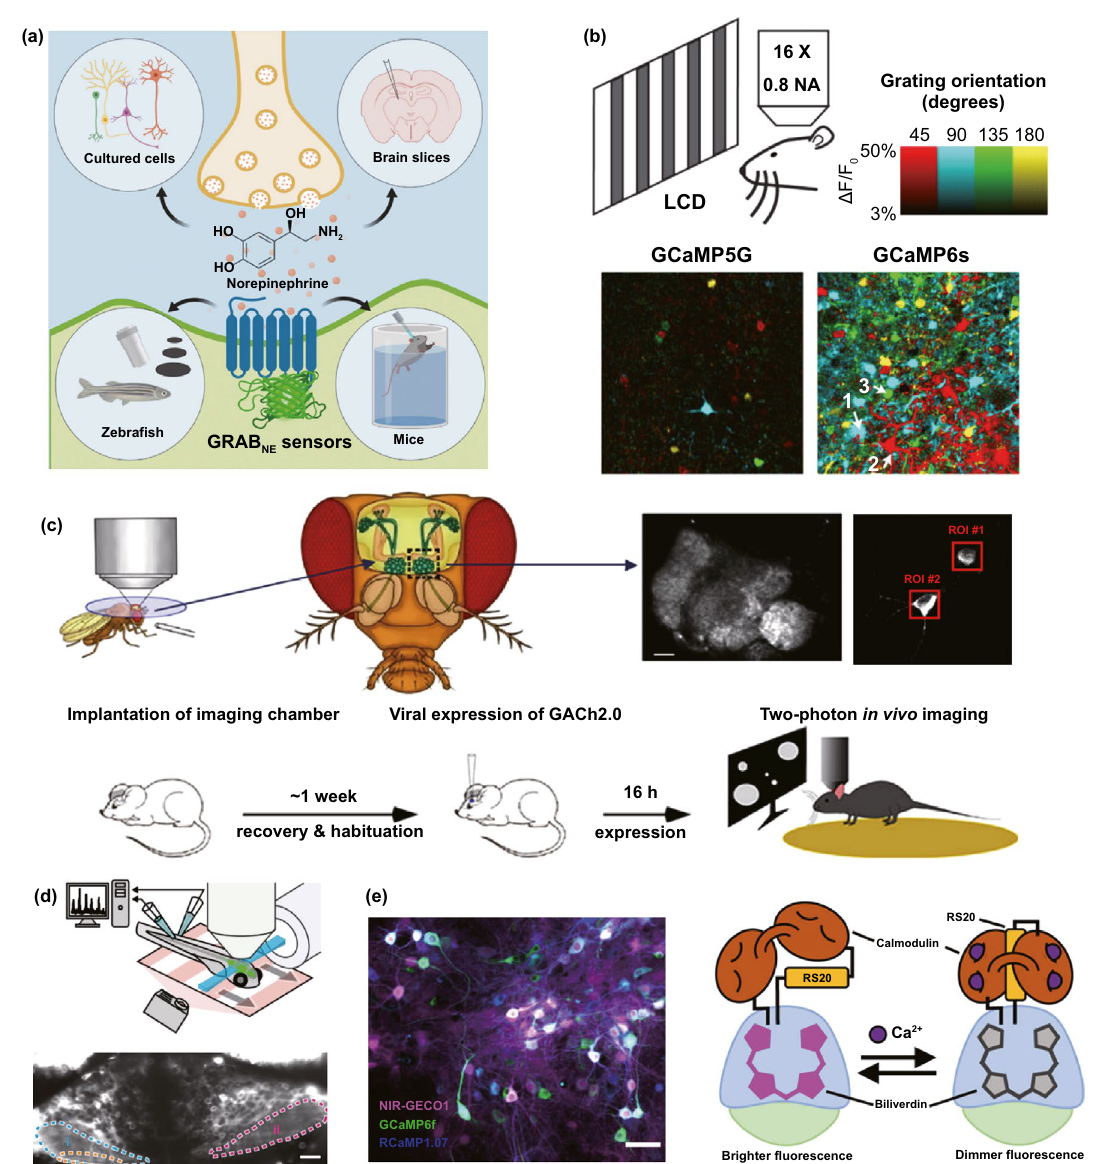
Fig. 19 Semi‑implantable optical sensor for brain in vivo. a Genetically encoded GPCR‑activation‑based on norepinephrine sensors for rapid in vivo specific detection for norepinephrine [342]. b In layer 2/3 pyramidal neurons of the mouse visual cortex, Ultra‑sensitive protein calcium sensors (GCaMP6) detected of single‑neuronal somatic action potentials and targeted regulation of synaptic transient calcium in single den‑ dritic spines [343]. c G‑protein‑coupled receptor activation‑based ACh (GACh) sensors responded to exogenous and/or endogenous ACh selec‑ tively with remarkable fluorescence signals that were recorded by epifluorescence, confocal and/or two‑photon microscopy from multiple animal species [344]. d Genetically encoded GABA fluorescent sensor for in vivo light‑sheet image of zebrafish cerebellum expressing [346]. e Spectral multiplexing of genetically encoded near‑infrared fluorescent calcium ion indicator NIR‑GECO1 with optogenetic indicators and actuators [337]. Reproduced with permission from Refs. [337, 342–344, 346], copyright (2019) Nature Publishing Group (2019) Cell Press Publishing